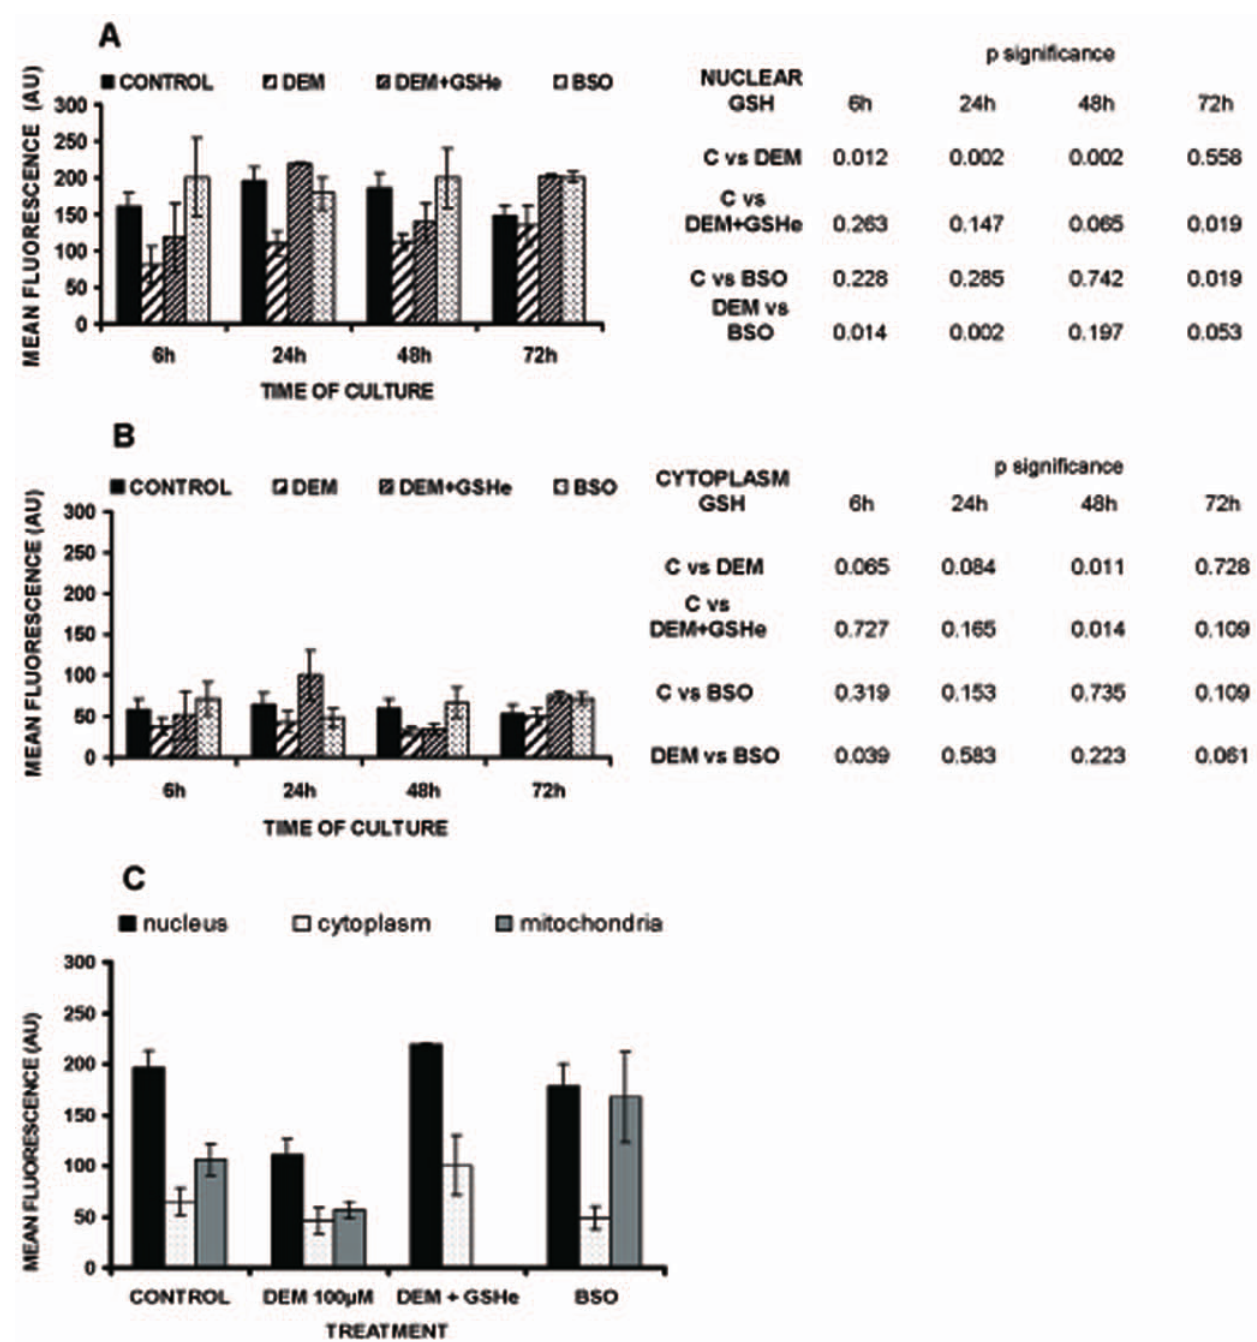
Figure 4. The effect of DEM and BSO treatment on the nuclear and cytoplasmic pool of GSH. The maximum projection images (as presented in the fig. 3) were analysed by area, as described in ‘‘Materials and Methods’’. CMFDA fluorescence in nuclear area (defined by Hoechst staining, see fig. 3) is presented in fig. 4A and the CMFDA fluorescence of the cytoplasm area (defined by transmission images, see fig. 3) is presented at fig. 4B. The results are mean values of at least 4 different experiments (50–100 cells per experiment). The level of CMFDA fluorescence in the nuclear, cytoplasmic and mitochondrial area after treatment with BSO and DEM at 24 h of culture is presented at the panel C. The analysis of nuclear and cytoplasmic area was performed as described. Mitochondrial area was considered to be marked by perinuclear green fluorescence, as demonstrated previously (4). The results are presented as mean of 3–5 different experiments. doi:10.1371/journal.pone.0006413.g004 level in these cells was lowest. On the other hand, these cells still BSO does not affect the redox state of the nucleus, when BSO is have increased oxidized nuclear proteins at day 6 of culture. Thus, used at low concentration (10 m M). However, 100 m M DEM is protein carbonyl levels did not rebound as glutathionylated able to deplete both cytosolic and nuclear glutathione, creating a proteins. Results show that the depletion of cytosolic GSH with nuclear environment prone to oxidation.